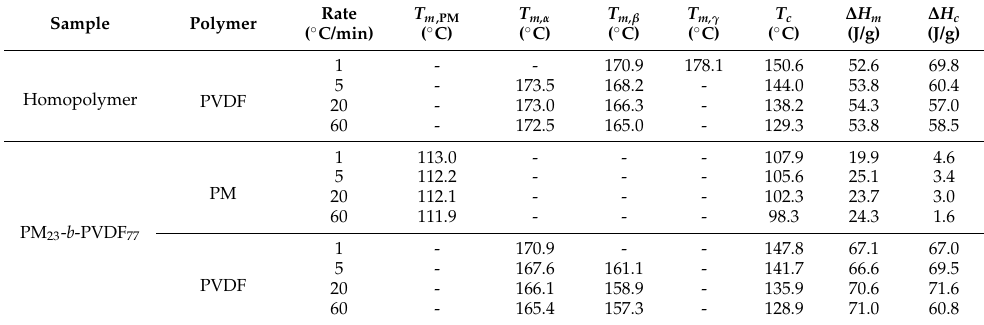
Figure 5. DSC heating scans for PVDF after different cooling rates were used: ( a ) PM 23 - b -PVDF 77 and ( b ) PM 38 - b -PVDF 62 block copolymers, ( c ) PM 23 PVDF 77 , ( d ) PM 38 PVDF 62 , and ( e ) PVDF homopolymer samples. Table 2. Melting and crystallization temperatures and enthalpies for each block copolymer, blend, and homopolymer sample